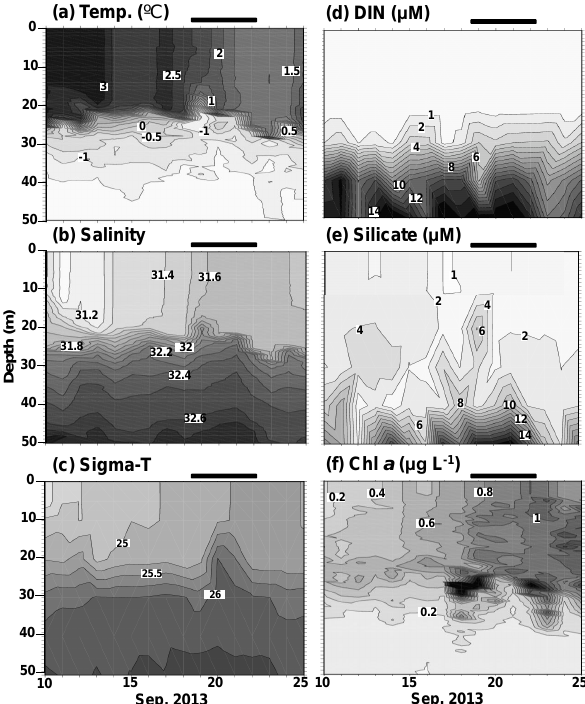
Figure 2. Temporal and vertical changes in temperature ( ◦ C) (a) , salinity (b) , sigma- T (c) , dissolved inorganic nitrogen (µM) (d) , sil- icate (µM) (e) and chlorophyll a (µgL − 1 ) (f) at a fixed station in the Chukchi Sea between 10 and 25 September 2013. Solid bars indicate the timing of the strong wind